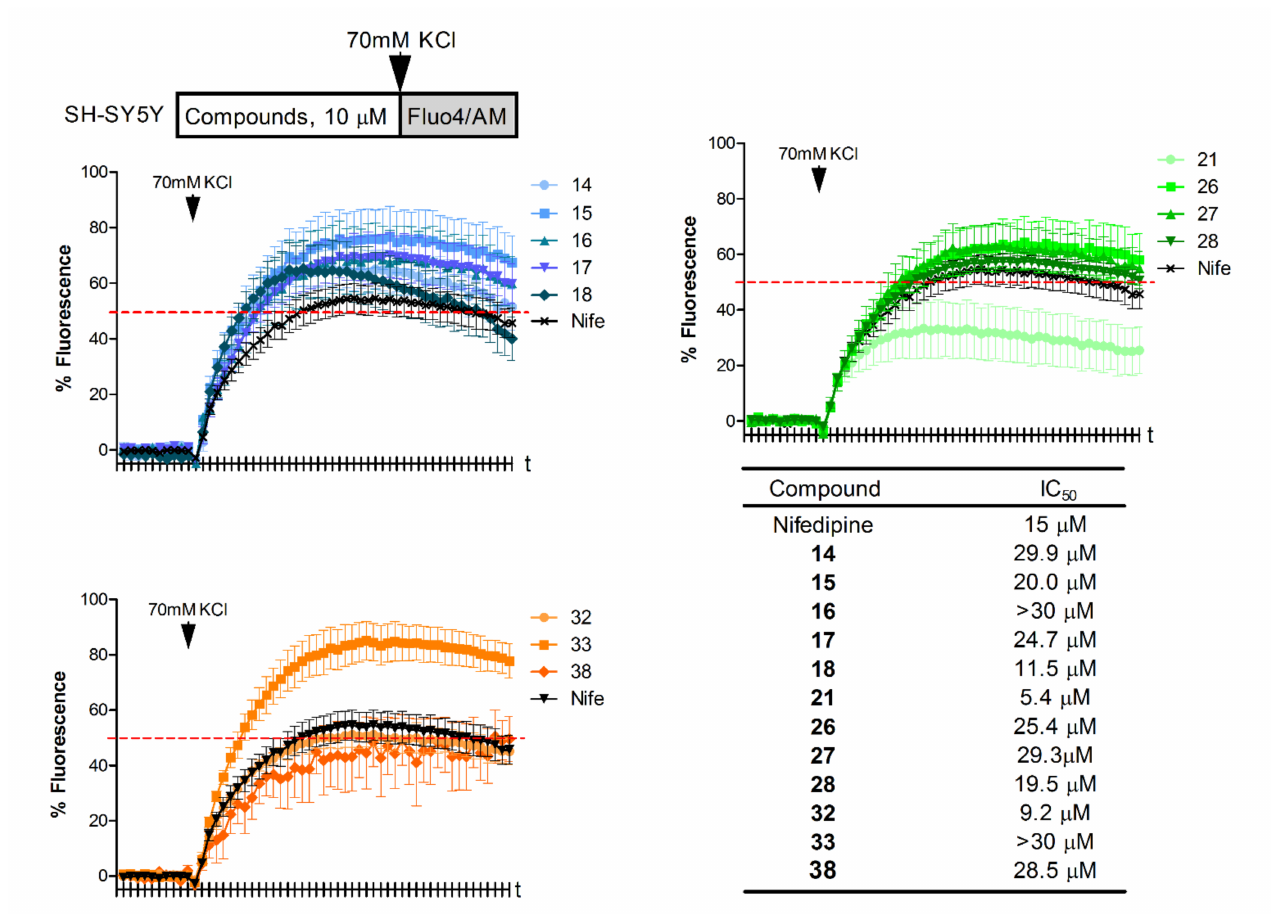
Figure 3. Representative fluorescent curve of [Ca 2+ ] c oscillations for each test compound and the standard nifedipine (Nife), at the concentration of 10 µ M. The curves represent the % of fluorescence compared to a control situation, i.e., cells just stimulated with 70 mM K + , and they are the mean ± SEM of at least 3 independent experiments by triplicate. Bottom right, table with the IC 50 data calculated from experiments using compounds concentrations from 1 to 30 µ